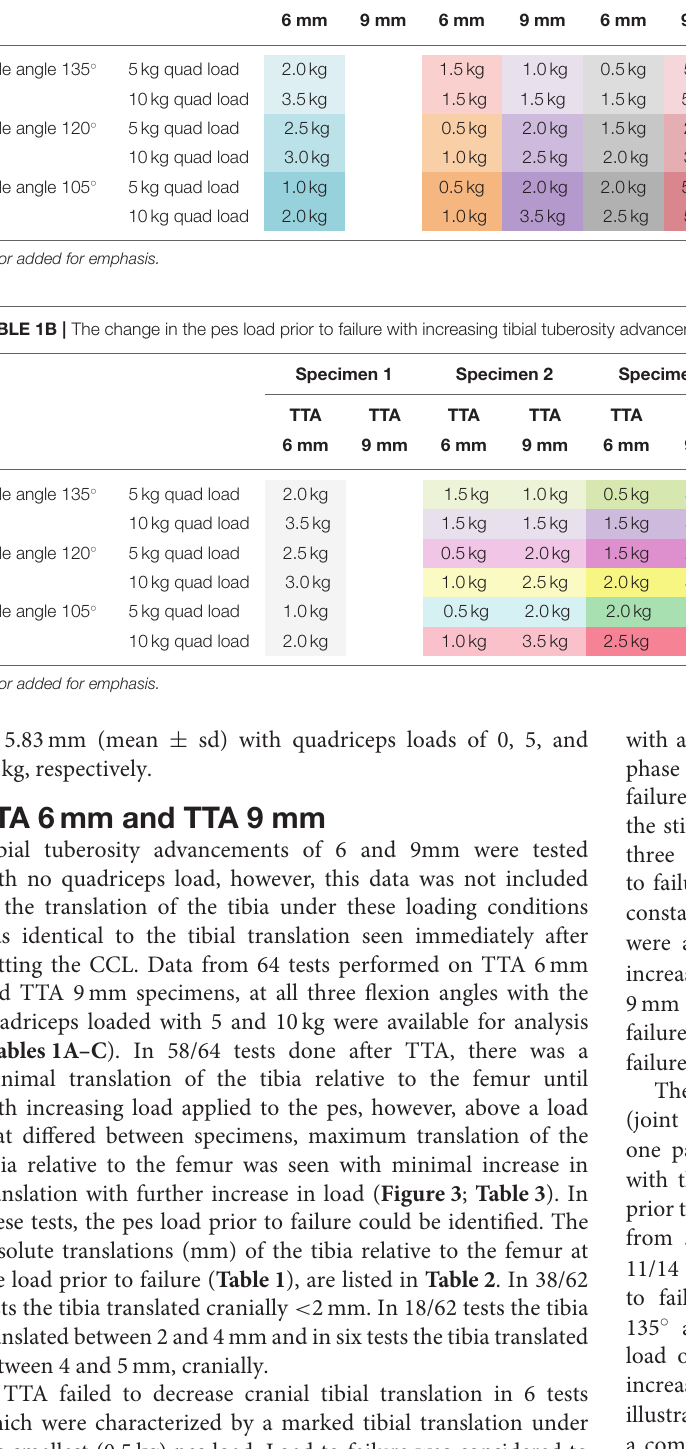
Stifle angle 105 ◦